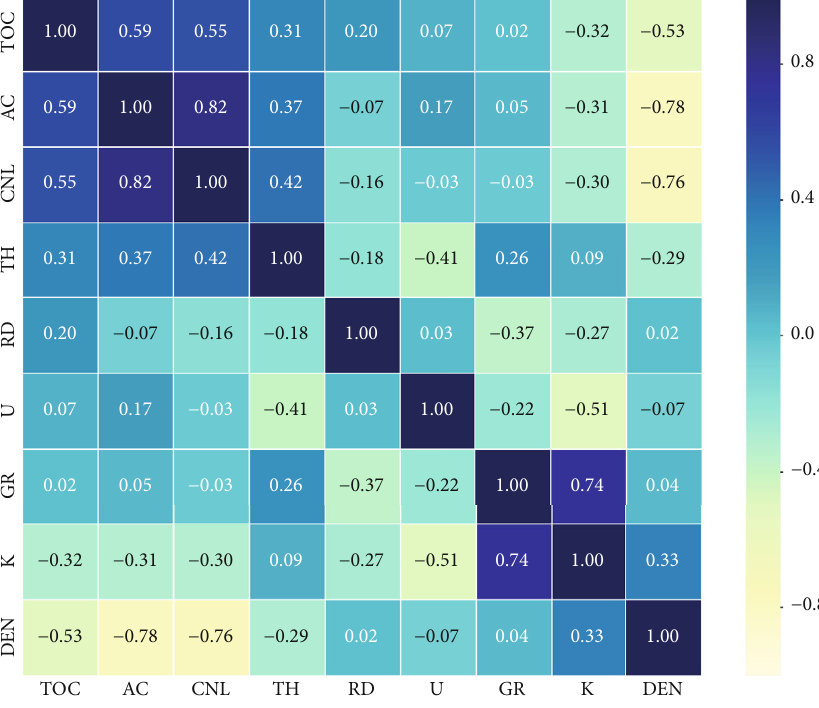
Figure 5: Heat map of Pearson ’ s correlation coe ffi